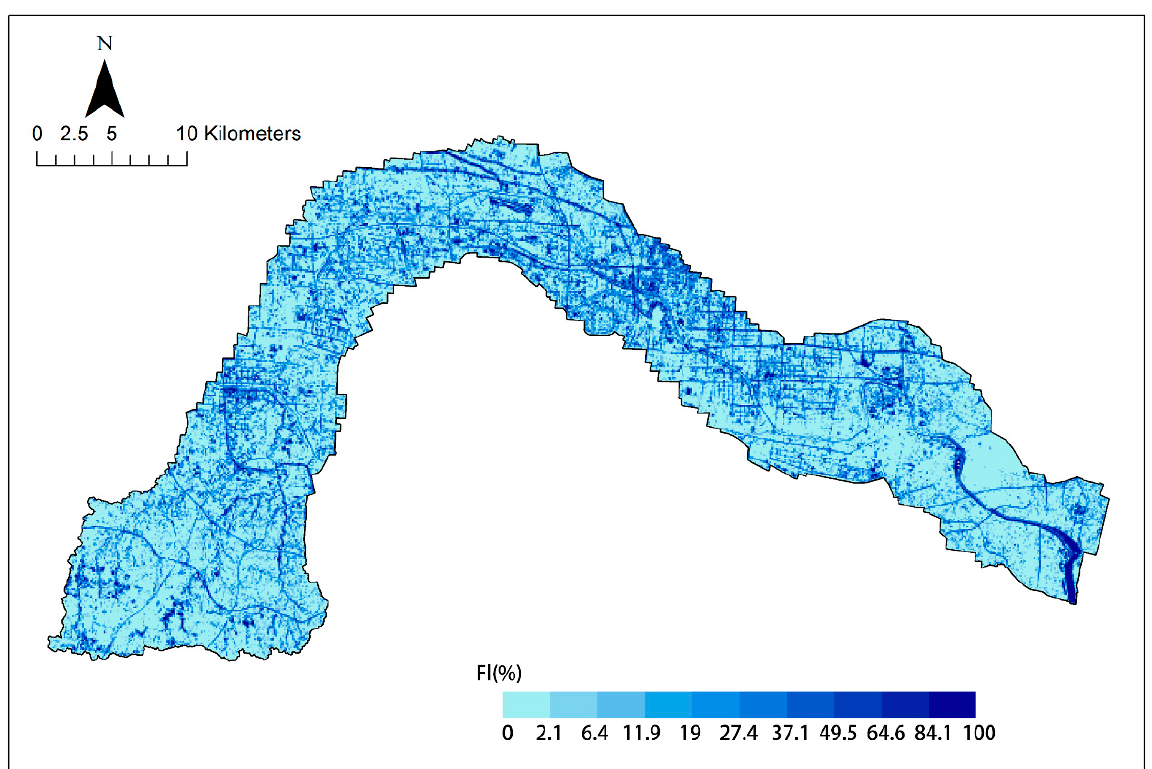
Figure 4. Flood inundation intensity (FI) at 10:31 pm on 20 July 2021 in the Jialu River System in greater Zhengzhou, China.